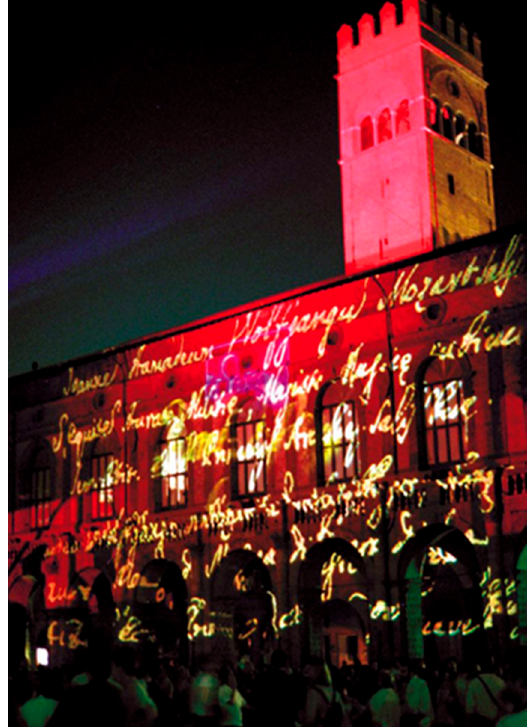
Figure 2. Light and video installation called Bologna Towers 2000, projected in the same year by English director Peter Greenaway over Piazza Maggiore buildings façades in Bologna. http://www.brodyneuenschwander.com/bologna-1/ (accessed on 13 July